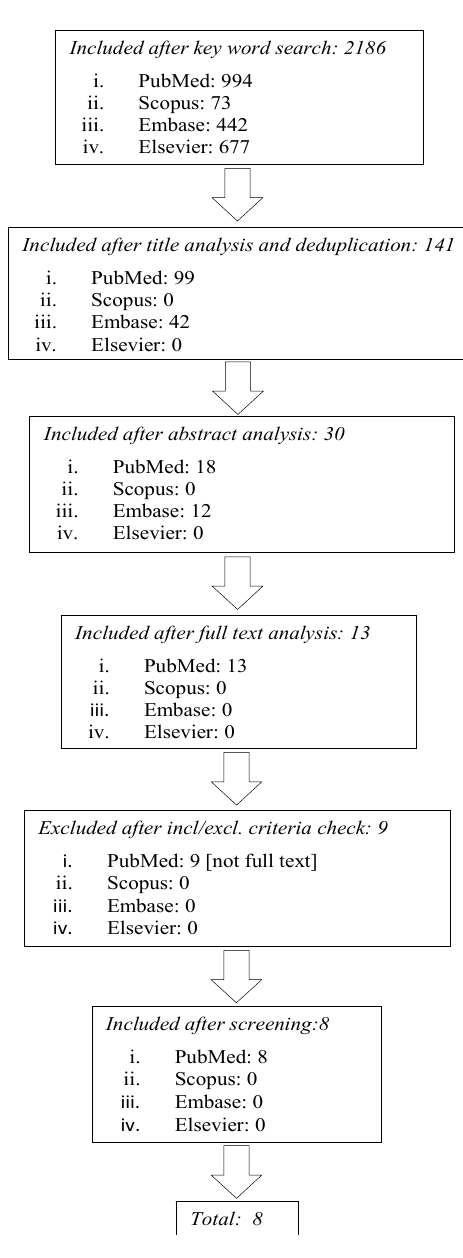
Figure 1. The flowchart search strategy.